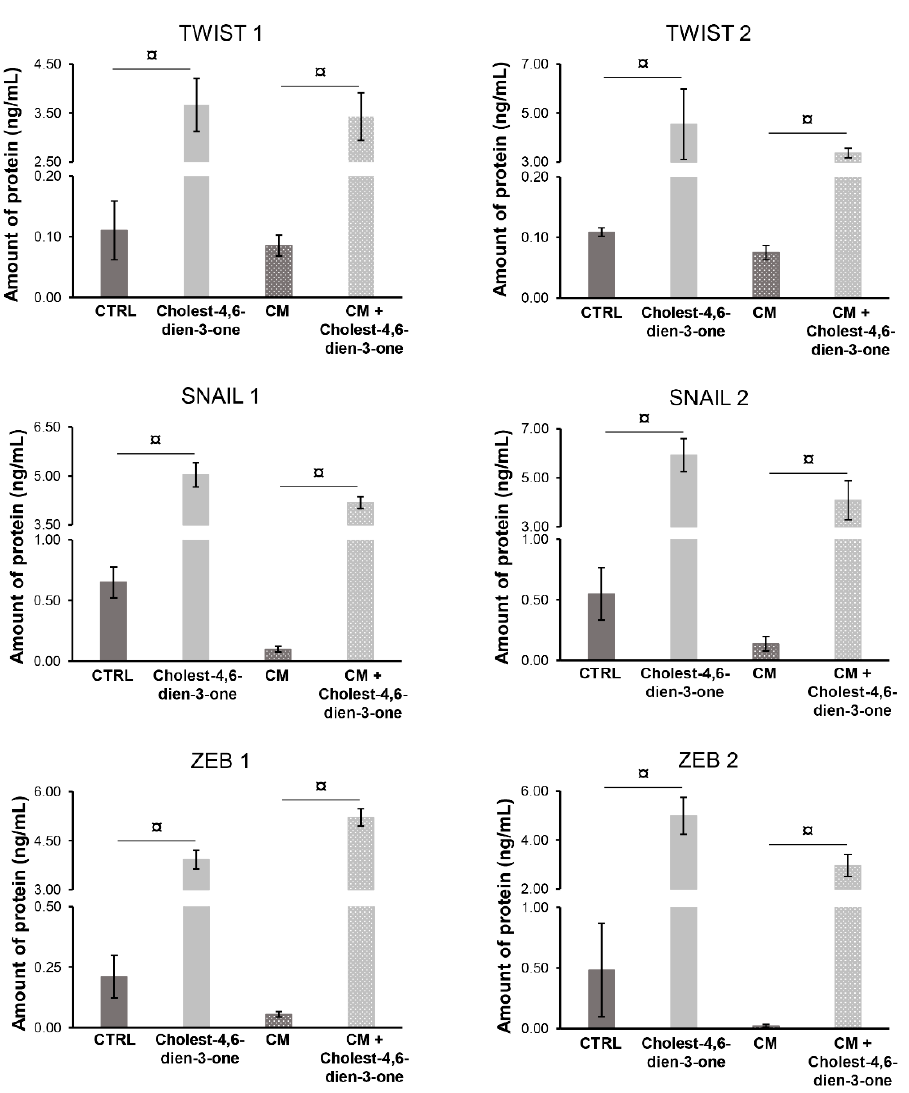
Figure 5. Cholest-4,6-dien-3-one enhanced the EMT markers analyzed by WB. Protein levels of EMT markers (TWIST1, TWIST2, SNAIL1, SNAIL2, ZEB1, and ZEB2) examined by WB of hBTSCs cultured in basal condition (KM), KM supplemented with cholest-4,6-dien-3-one, differentiation tailored cholangiocyte medium (CM) or CM added with cholest-4,6-dien-3-one. Data expressed as mean ± SD of N = 6 experiments; ¤ p < 0.0001.